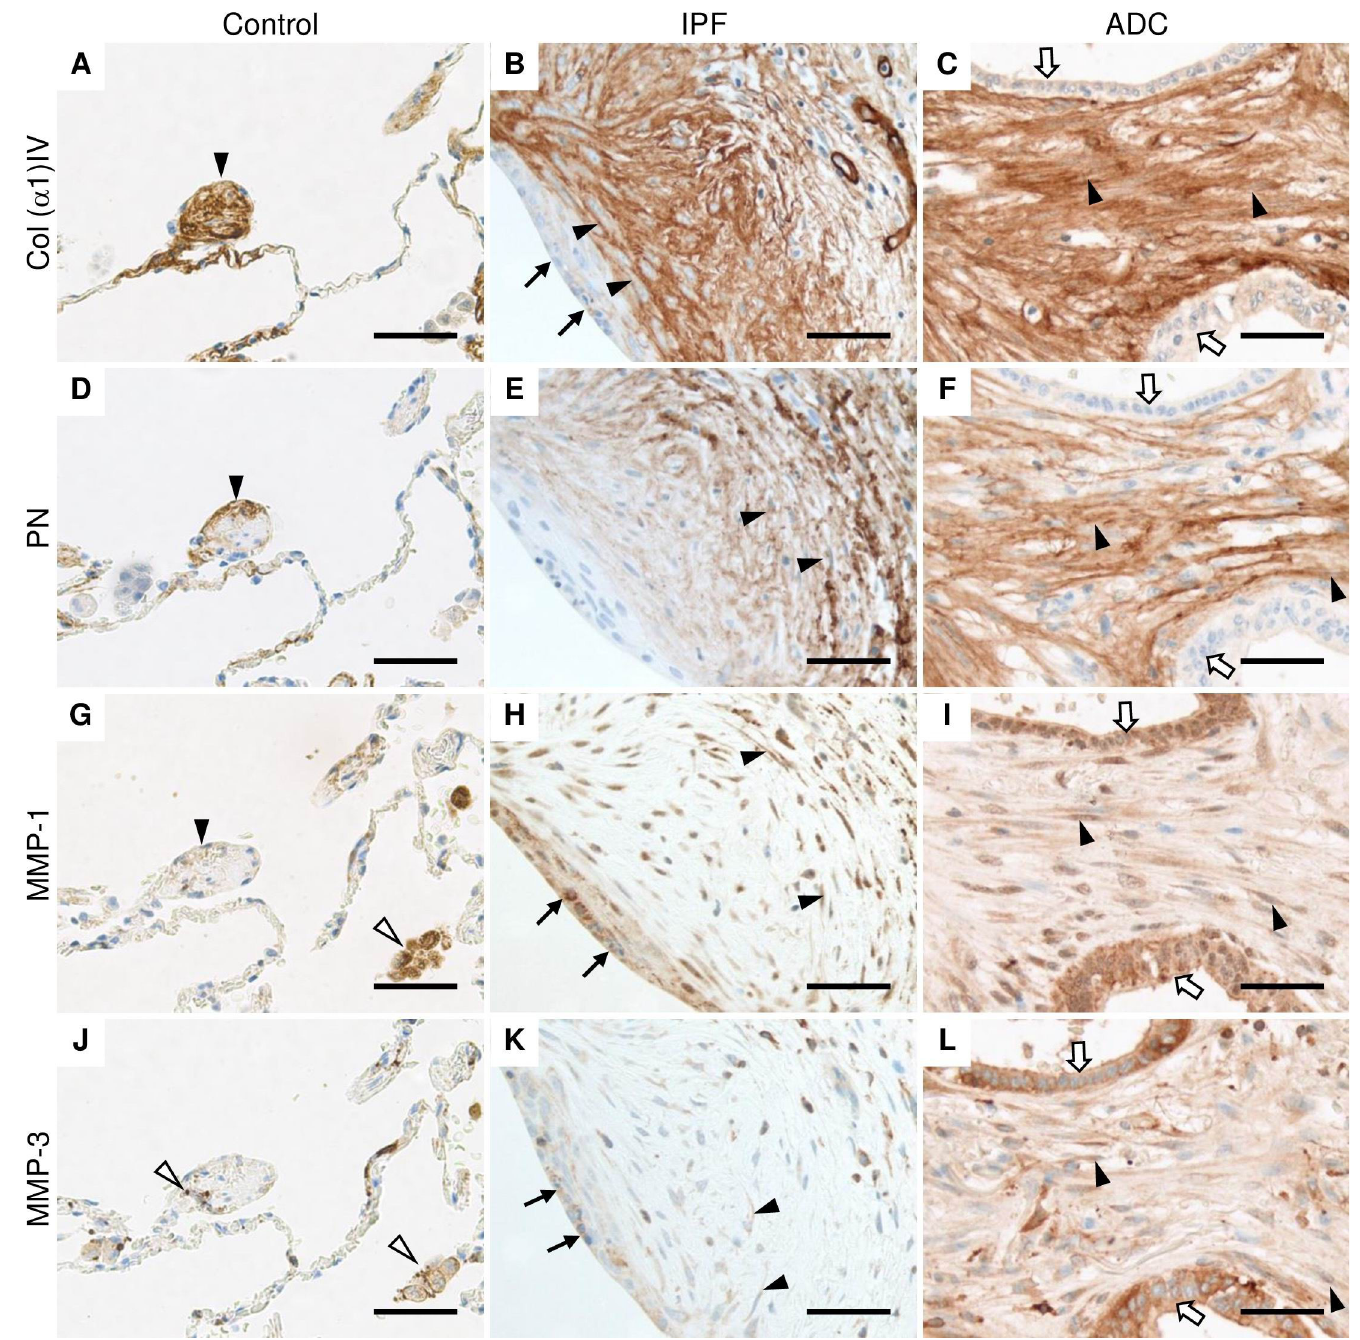
Fig 2. Immunohistochemical localization of Col α 1(IV), PN, MMP-1 and MMP-3 in normal control lung, IPF and ADC. Sections were obtained from patients with lung adenocarcinoma (ADC) from both the tumor area and histologically normal lung as well as from patients with idiopathic pulmonary fibrosis (IPF). (A, B and C) Stromal cells of control lung, IPF and ADC were strongly positive for collagen (Col) α 1(IV) chain (black arrow heads), while hyperplastic alveolar epithelial cells lining fibroblast focus (black arrows) and cancer cells (white arrows) were weakly positive. (D, E, and F) Stromal cells of control lung, IPF and ADC were positive for periostin (PN) (black arrow heads). (G) Alveolar macrophages (white arrow heads) were strongly positive for matrix metalloproteinase (MMP) -1, while cells with a widened alveolar tip of normal lung were weakly positive (black arrowhead). (H) Stromal cells (black arrow heads) and epithelial cells lining fibroblast foci (black arrows) in IPF were positive for MMP-1. (I) Cancer cells (white arrows) and stromal cells (black arrow heads) of ADC were positive for MMP-1. (J) Alveolar macrophages and monocyte lineage cells (white arrow heads) were positive for MMP-3 in normal lung. (K) Hyperplastic alveolar epithelial cells (black arrows) and some stromal cells (black arrow heads) were positive for MMP-3 in IPF. (L) Stromal cells (black arrow heads) as well as cancer cells (white arrows) were positive for MMP-3. Scale bar 50 μ m.